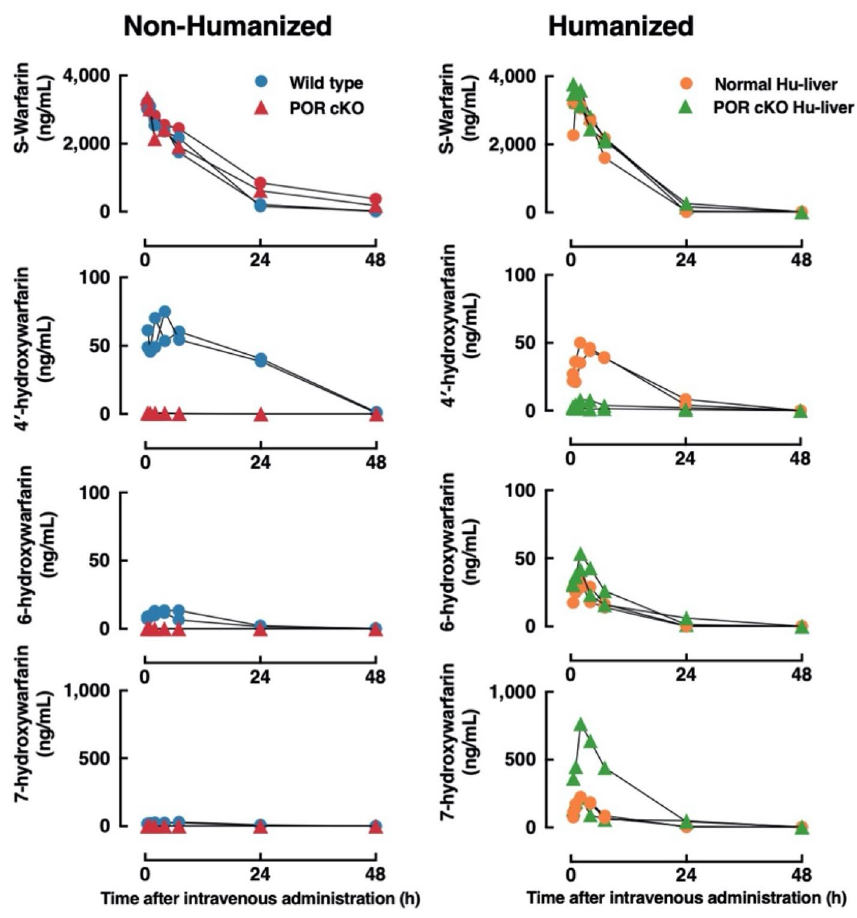
Figure 6. Plasma concentration of S -warfarin and its hydroxy metabolites after the intravenous administration of S -warfarin (4.0 mg/kg) in non-humanized liver mice and humanized liver mice. The plasma concentrations of S -warfarin, 4 ′ -hydroxywarfarin, 6-hydroxywarfarin, and 7-hydroxywarfarin in wild-type (circle) or POR cKO (triangle) mice with non-humanized or humanized livers were measured at 0.5, 1, 2, 4, 7, 24, 48, and 72 h after the intravenous administration of S -warfarin (4.0 mg/kg). Each group consists of two mice. The levels of 8- and 10-hydroxywarfarin were below the detection limit in all